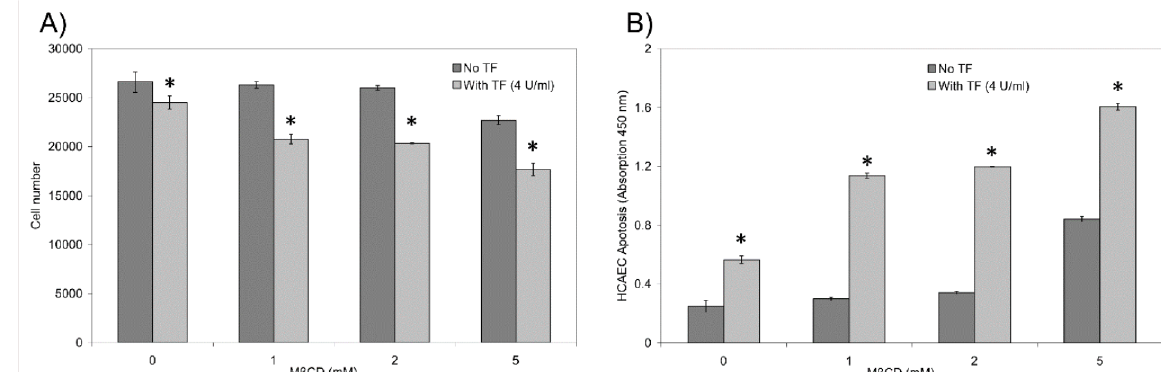
Figure 7. Analysis of the influence of recombinant TF on cell viability before and after cholesterol depletion: HDBEC (2 10 4 ) were seeded in 96-well plates containing complete medium and incubated overnight. On the following day, the × media was removed, and the cells were treated with a range of concentrations of M β CD (0–5 mM) diluted in serum-free MV medium ( w / v ) for 1 h at 37 ◦ C. After the incubation, the cells were washed twice with PBS and incubated with complete MV medium, in the presence or absence of TF (4 U/mL = 5.2 ng/mL) for 24 h at 37 ◦ C. ( A ) Cell numbers were then determined using crystal violet assay as above. ( n = 4; * = p < 0.05 vs. the respective sample without M β CD). ( B ) Cellular apoptosis was quantified in selected samples using the TiterTACS™ Colorimetric Apoptosis Detection Kit (AMS Biotechnology, Abingdon, UK) according to the manufacturer’s instructions. ( n = 3; * = p < 0.05 vs. the respective sample without